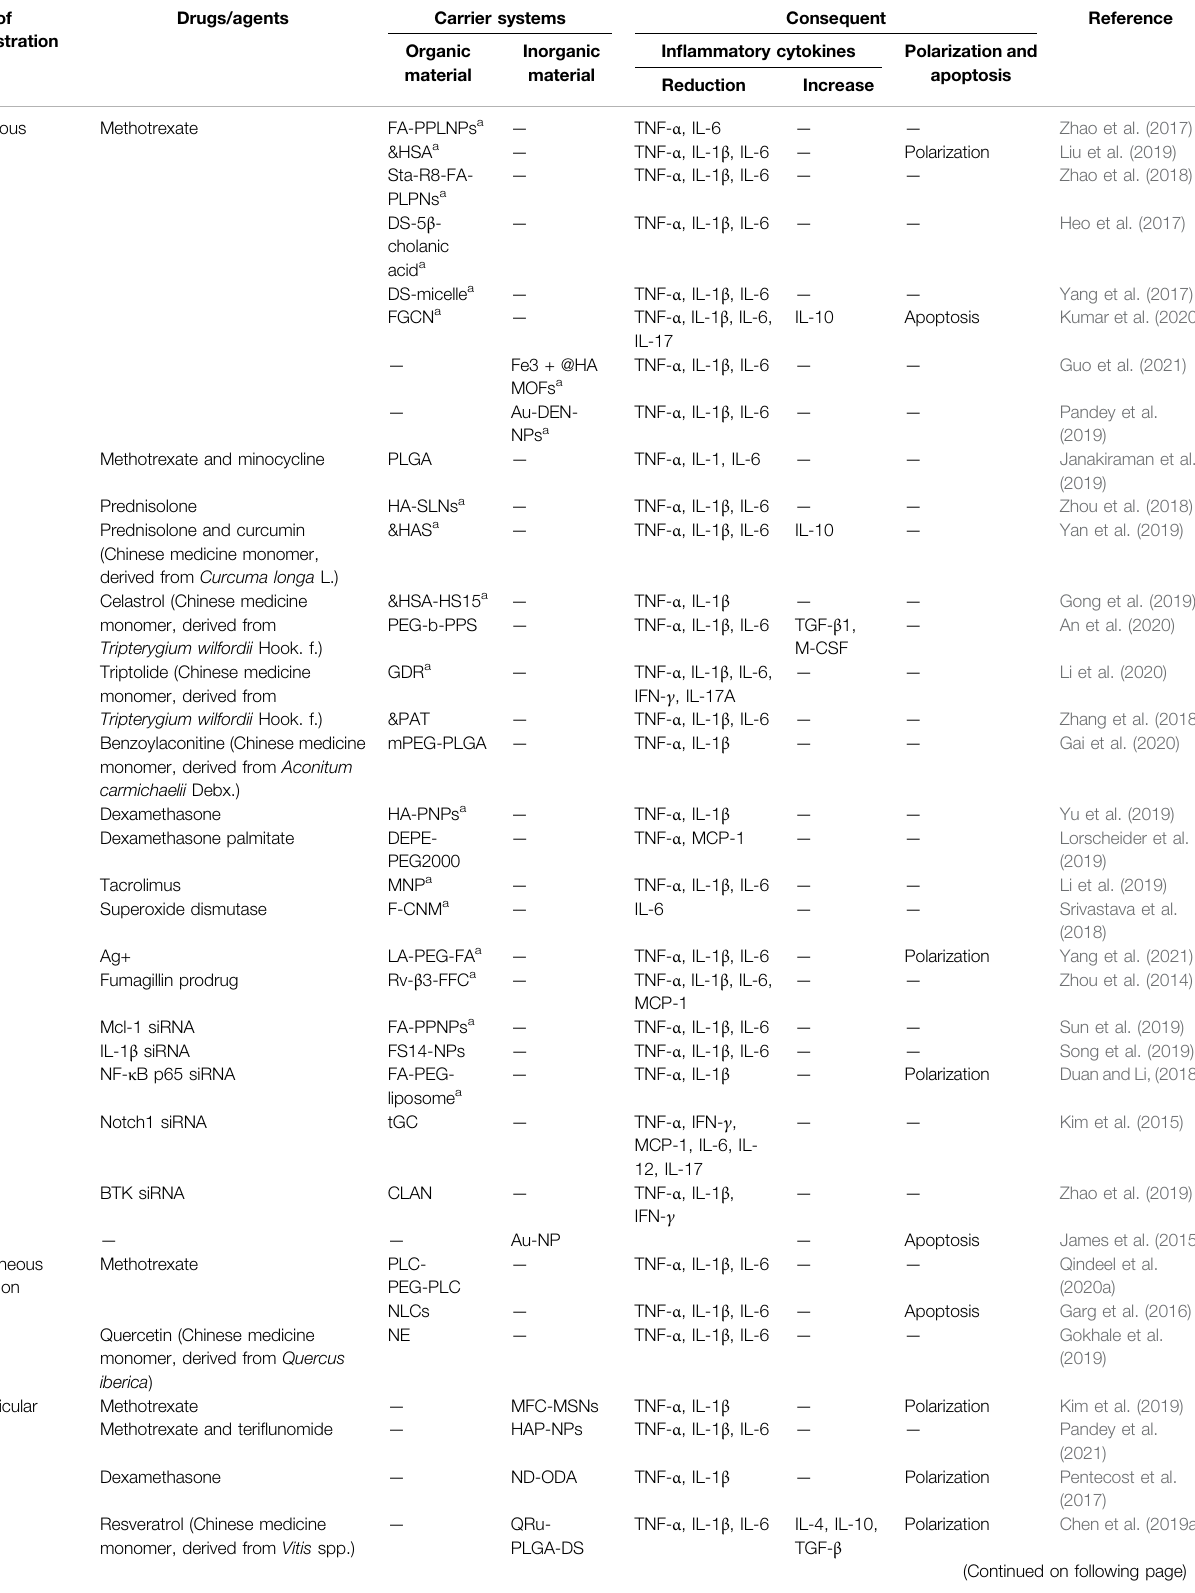
TABLE 1 | Strategies using nanomaterials to manipulate macrophages for Rheumatoid arthritis treatment. Route of